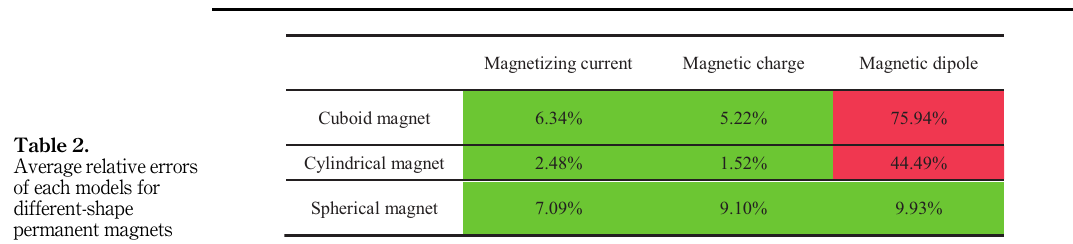
Table 1. Magnetization values of different-shape permanent magnets based on each model